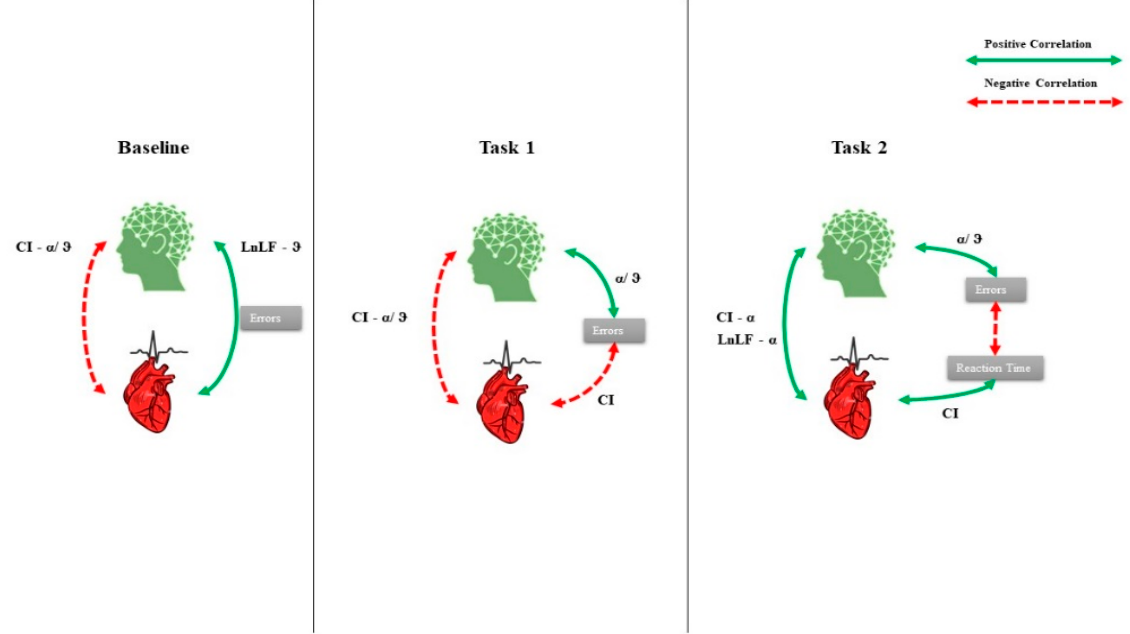
Figure 4. Correlation between HRV parameters (Complexity Index (CI), HF power (LnHF), LF power (LnLF)) and EEG α , ϑ , and α / ϑ ratio EEG powerbands of the whole group. Green and dashed red lines are the positive and negative correlations, respectively.